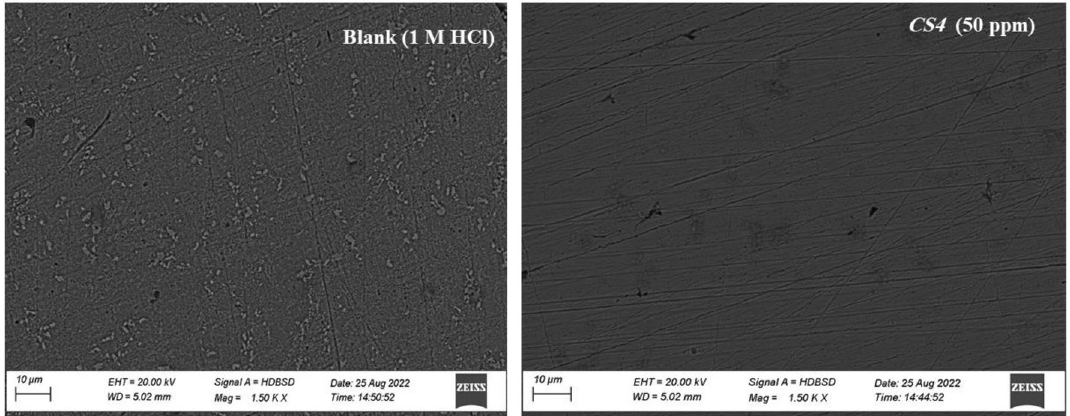
Figure 13. SEM images of the uninhibited (1 M HCl) and the inhibited (50 ppm CS4 ) CS -metal after 6 h at room